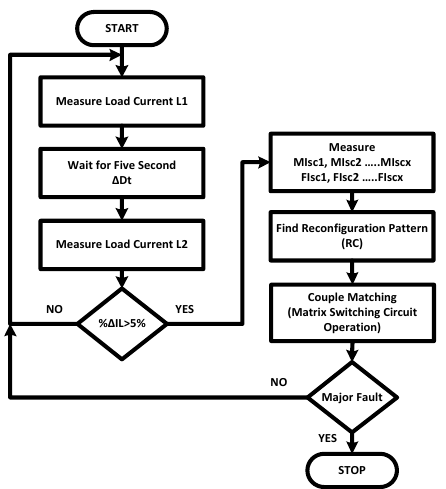
Figure 3. Flow chart of the proposed algorithm.